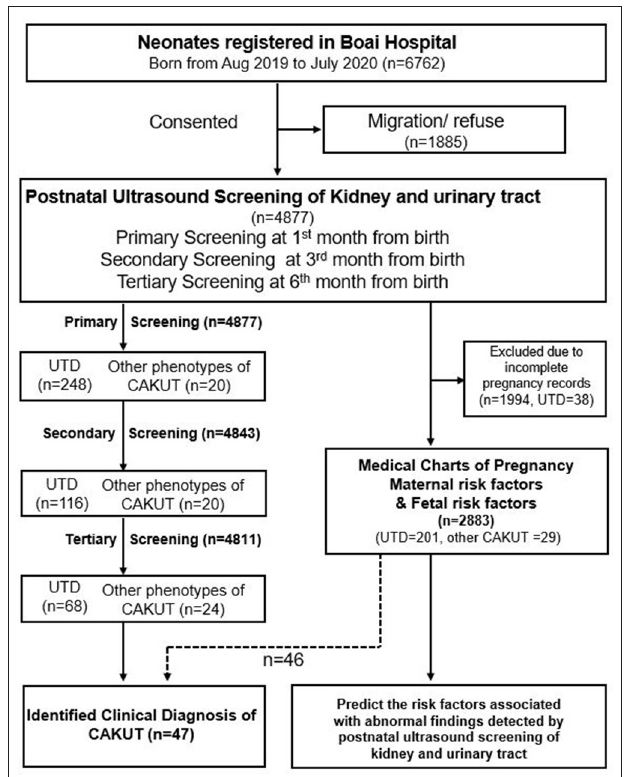
FIGURE 1 | Flowcharts of study participants. CAKUT, congenital anomalies of the kidney and urinary tract; UTD, urinary tract dilation.